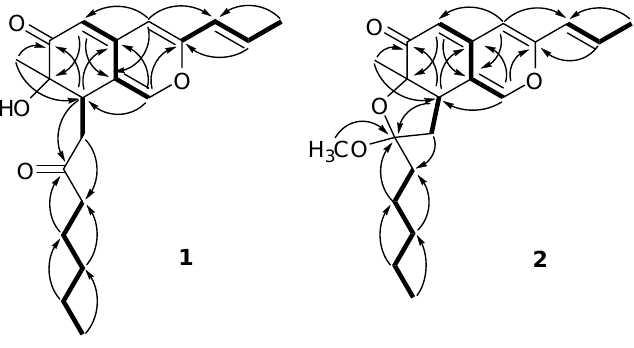
Figure 2. Main 1 H- 1 H COSY (bold lines) and HMBC (arrows) correlations of compounds 1 and 2 .